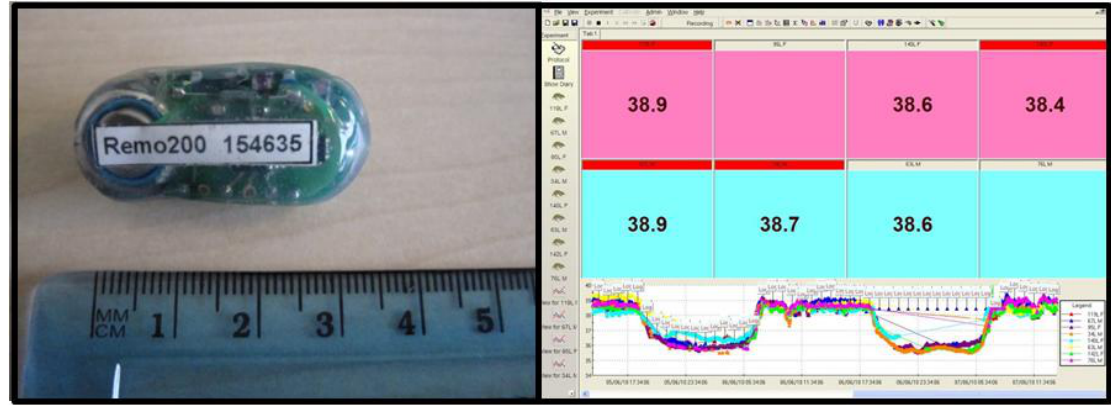
Figure 4. Telemetry System. Temperature implants (Remo Technologies) ( left ) are surgically implanted intra peritoneally into animals prior to a study commencing. The implants give real time core body temperature readings, updated every 30 seconds. The data is viewed ( right ) and collected in eDacq software and can be analysed in Microsoft Excel. Implants can be read when animals are pair/multiply housed. Implants can be upgraded with extra attachments, and further surgery can allow for additional readings such as hear rate or ECG etc .